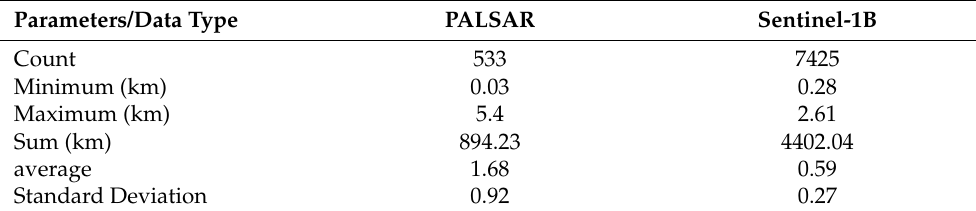
Table 4. Basic statistics of the extracted lineaments from PLASAR and Sentinel-1B. Parameters/Data